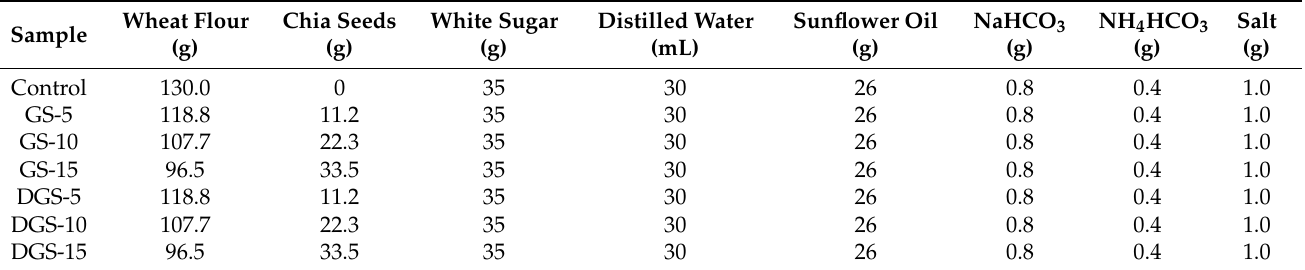
Table 1. Recipes for the elaboration of wheat-based biscuits (control) with added ground chia seeds (GS) and defatted ground chia seeds (DGS) at 5, 10 and